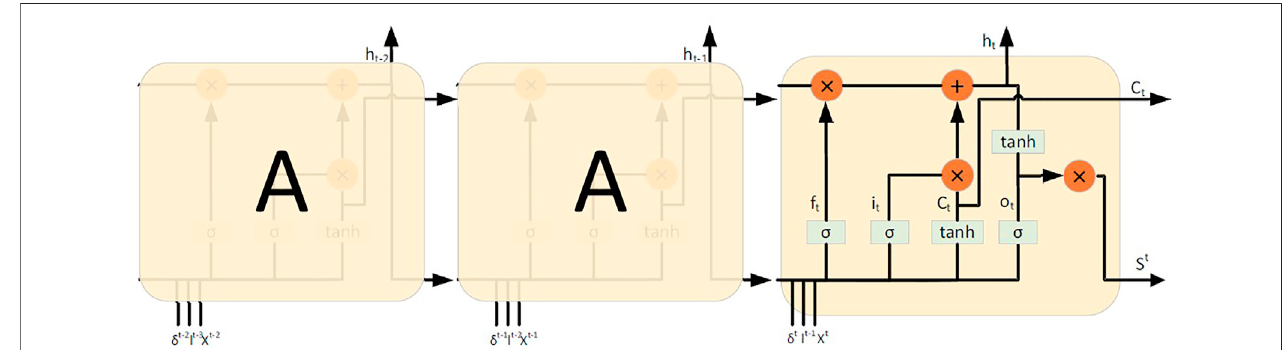
FIGURE 4 | T-LSTM